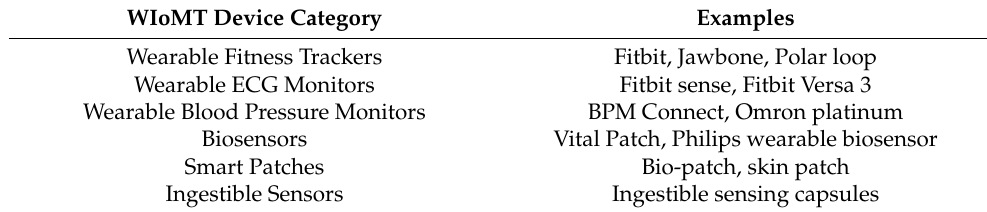
Table 1. Practical examples of WIoMT